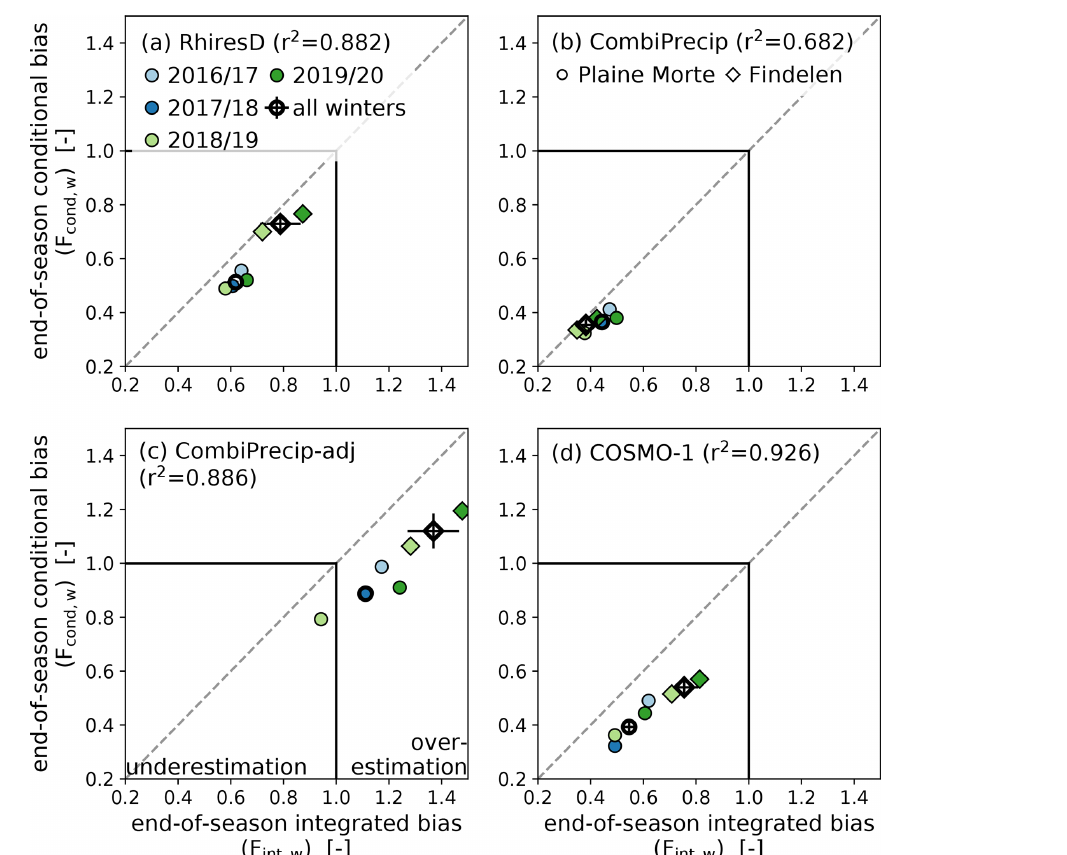
Figure 2. End-of-season bias derived with the accumulated (integrated) SWE amounts and cumulative precipitation during the accumulation season ( F int , w ), and derived based on event-days during the accumulation season (conditional bias, F cond , w ) for the precipitation products (a) RhiresD, (b) CombiPrecip, (c) CombiPrecip-adj and (d) COSMO-1. On Plaine Morte, four winter seasons (2016/17–2019/20), and on Findelen two winter seasons (2018/19–2019/20) are available. The dashed grey line shows a one-to-one correlation. Values below (above) one show an underestimation (overestimation) of precipitation compared to in situ SWE observations (black solid lines). The uncertainty of the bias over all winter seasons ( F int , F cond ) is calculated with a leave-one-out cross